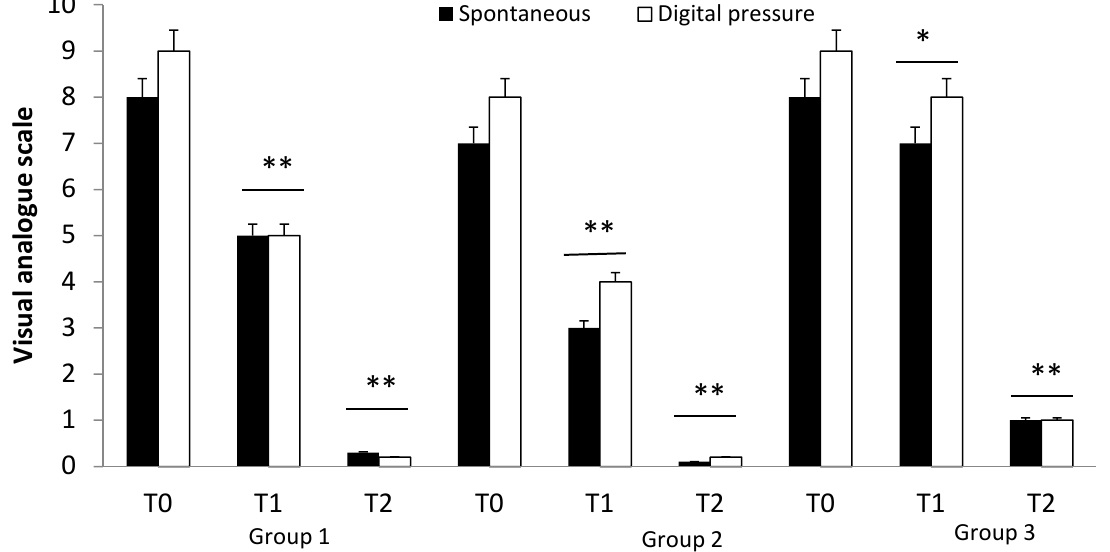
Figure 1. Effect of drug treatment, at different times (T0: admission), in patients enrolled in three groups. Group 1: patients treated with fondaparinux (7.5 mg/day subcutaneous) for 30 days (T1) and then nattokinase (for 30 days, T2). Group 2: patients treated with enoxaparin (6000 IU/day s.c.) for 30 days (T1) and the nattokinase (for 30 days) (T2). Group 3: Patients underwent classical surgery including ligature and section at the saphenofemoral junction and collateral veins and saphenousectomy (T1) and were treated one day later with nattokinase (for 30 days). * p < 0.05; ** p < 0.01.